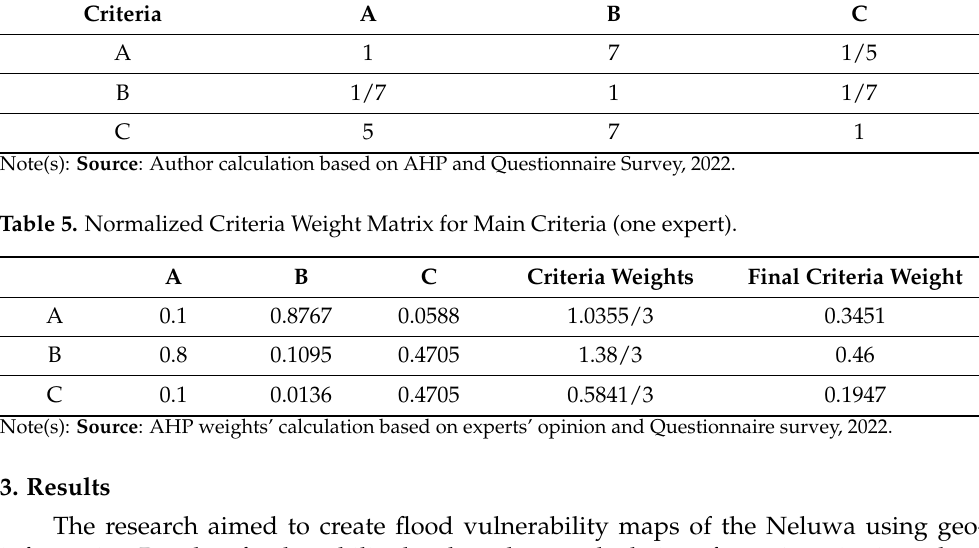
Table 4. Main Criteria Weight Matrix (one expert). Criteria